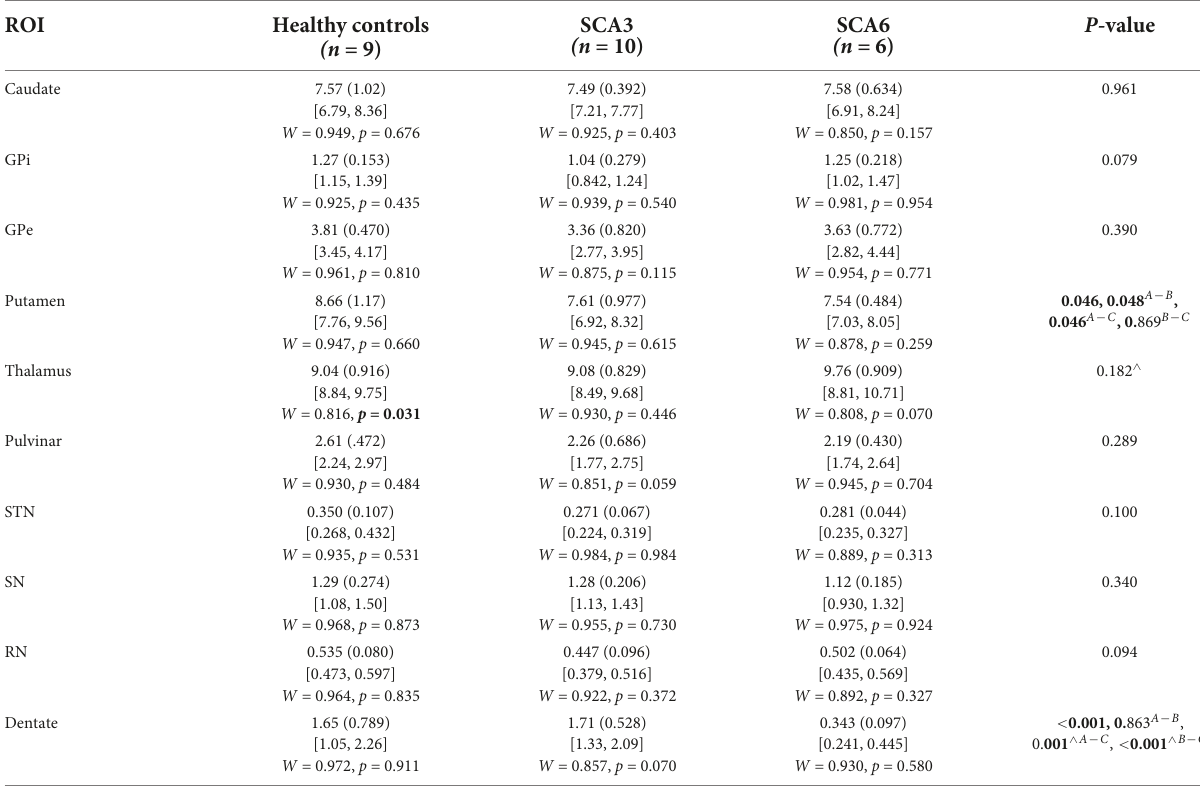
TABLE 3 Corrected ROI volumes (in the unit of 10 3 mm 3 ) compared across